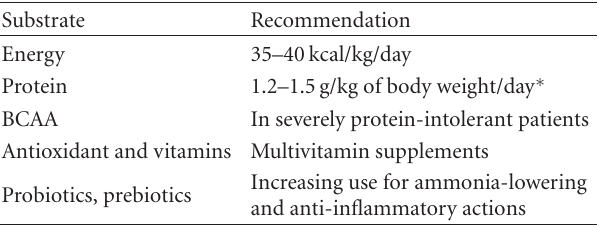
Table 2: Nutritional recommendations for the management of HE in end-stage liver